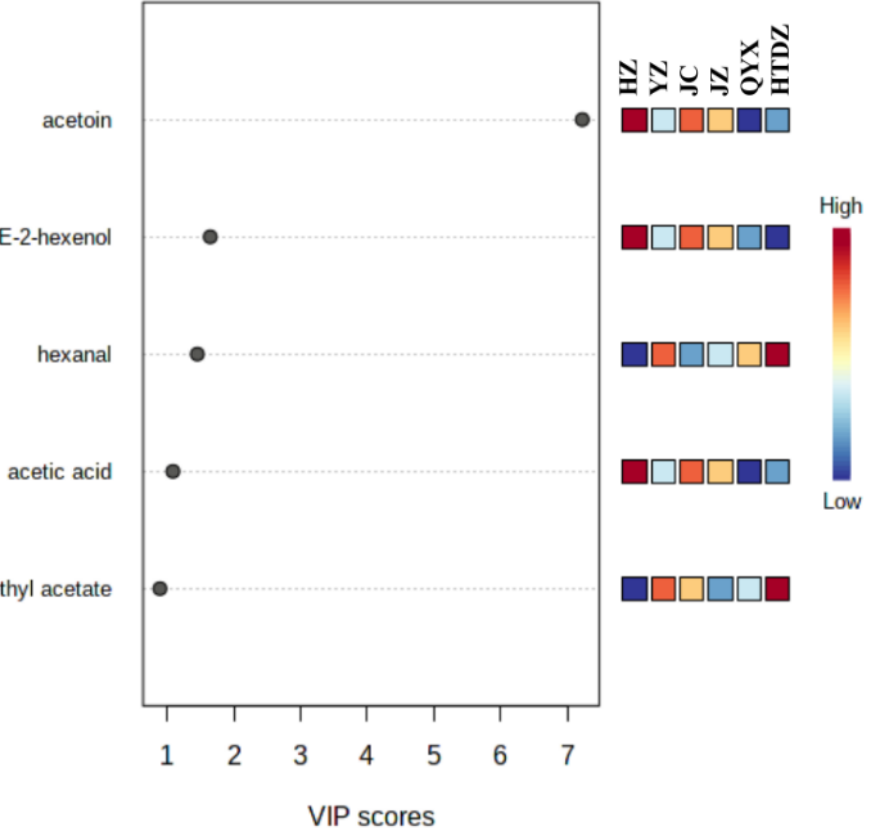
Figure 5. Volatiles with variable importance in projection (VIP) scores over 1 in the six red jujube vars from Xinjiang Province, China (Jinchang—‘JC’, Junzao—‘JZ’, Huizao—‘HZ’,Qiyuexian—‘QYX’, cultivars from Xinjiang Province, China (Jinchang —‘JC’, Junzao—‘JZ’, Huizao—‘HZ’,Qiyuexian— ‘QYX’, Hetiandazao—‘HTDZ’, and Yuanzao—‘YZ’) . Hetiandazao—‘HTDZ’, and